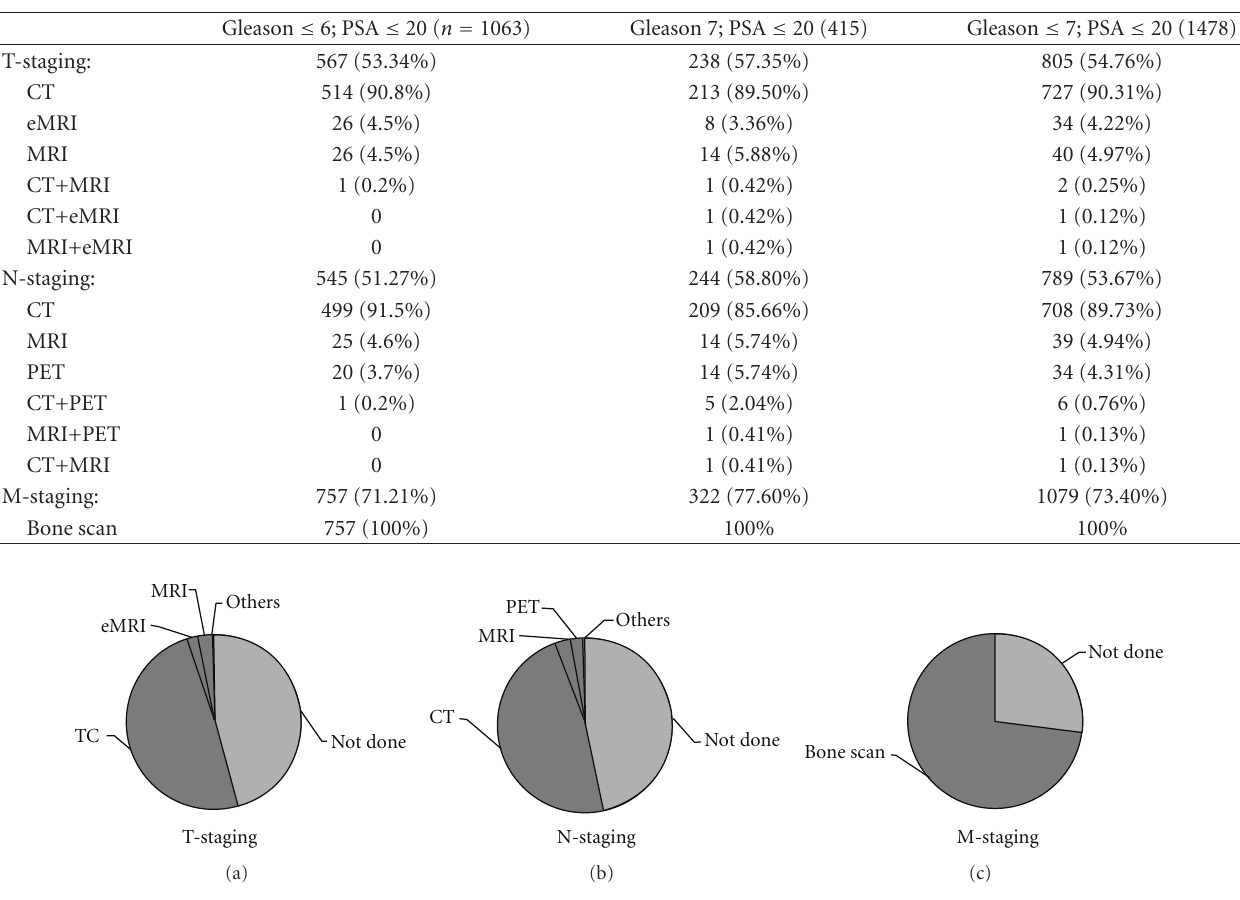
Table 3: Preoperative imaging staging among patients who could avoid it.